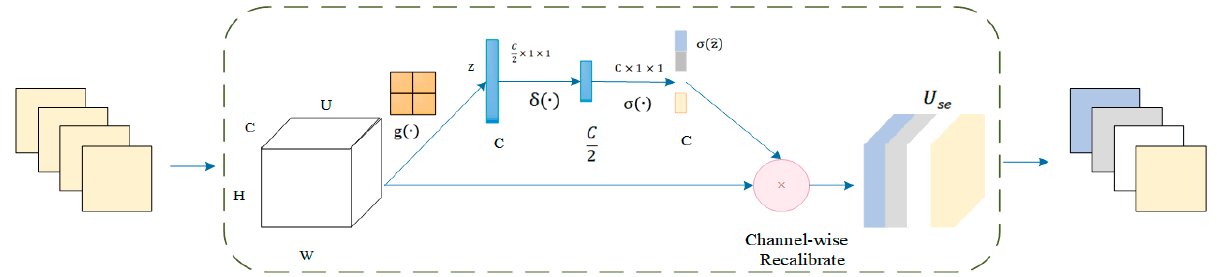
Figure 3. Architecture of the squeeze and excitation model.